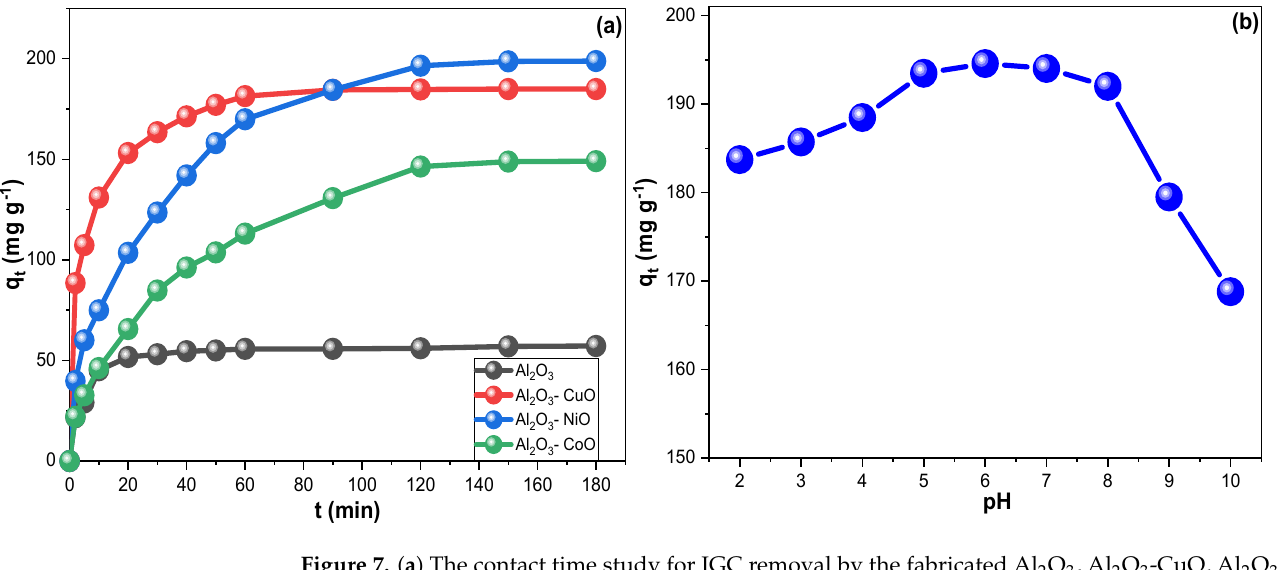
Figure 7. ( a ) The contact time study for IGC removal by the fabricated Al 2 O 3 , Al 2 O 3 -CuO, Al 2 O 3 - NiO, and Al 2 O 3 -CoO nanomaterials; ( b ) The pH influence on the removal of IGC dye by the Al 2 O 3 - NiO nanocomposite.